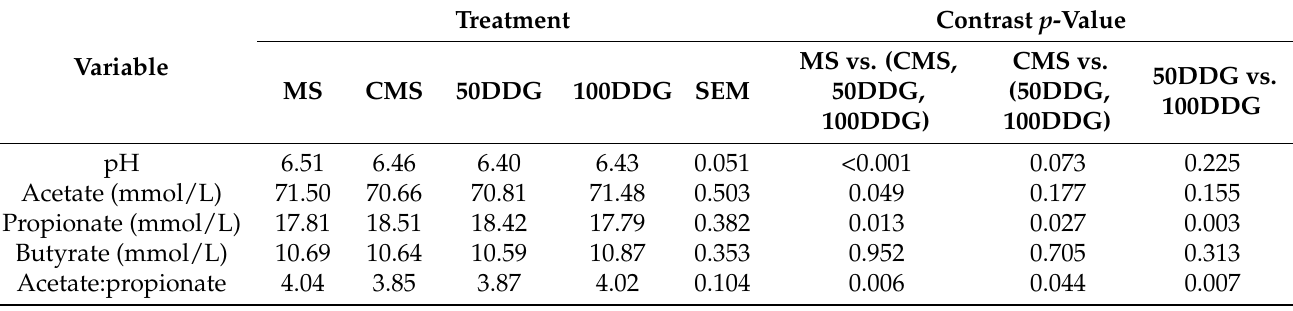
Table 5. Ruminal parameters of cannulated young bulls fed with mineral supplementation (MS); conventional multiple supplement (energy/protein) with cottonseed meal and citrus pulp (CMS); supplement with 50% of CMS protein source replaced by DDG (50DDG); and supplement with 100% of CMS protein source replaced by DDG (100DDG), grazing Marandu grass during the wet